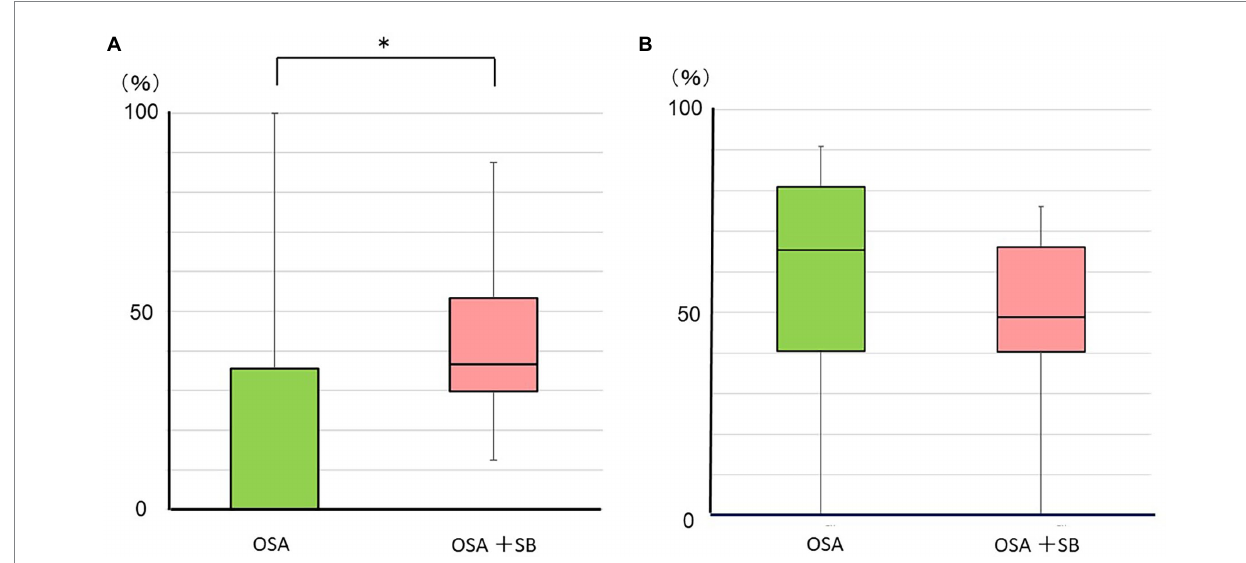
FIGURE 1 Temporal relationship between oromotor and respiratory events. (A) The percentage of RMMA following respiratory events. A significantly higher percentage of RMMA was scored during the 10-s period after respiratory events in the OSA + SB group (* p < 0.01: the Mann–Whitney U -test). (B) The percentage of NSMA following respiratory events. OSA: obstructive sleep apnea without sleep bruxism group. OSA + SB: obstructive sleep apnea with sleep bruxism group.